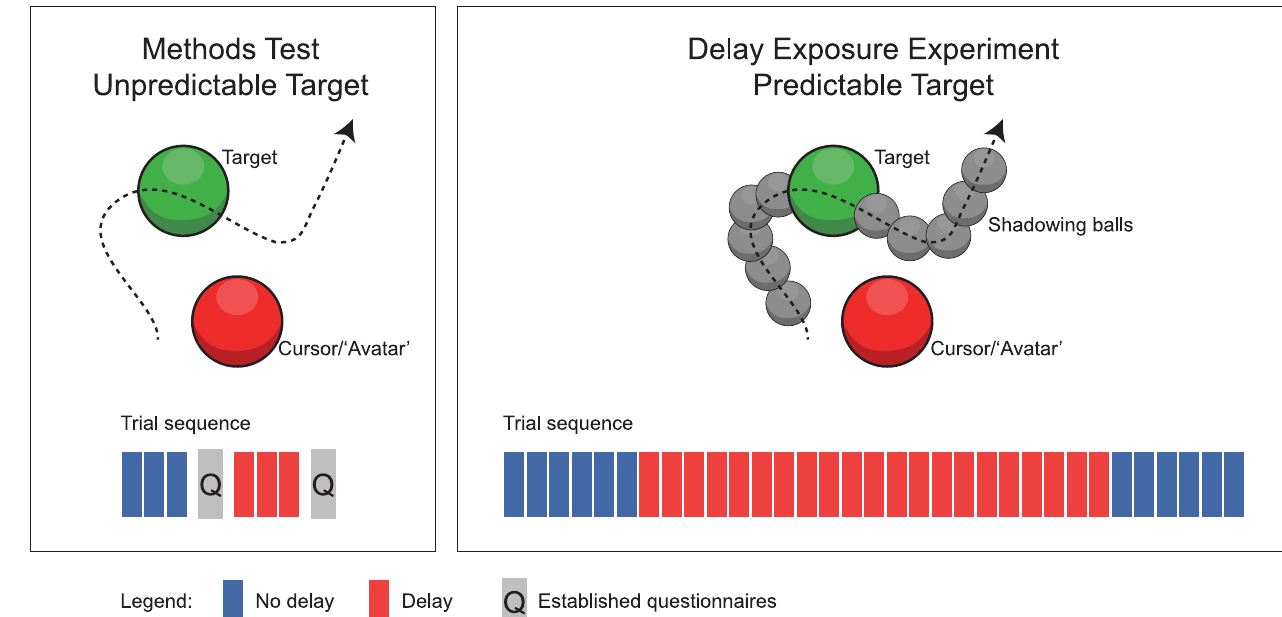
Fig 1. Schematic representation of stimulus and procedure of the experiment. The experiment consisted of two stages. In the first stage participants performed three trials for each of the No-Delay and Delay conditions after which they filled in the established questionnaires (left panel). In the second stage (right panel) participants first performed 6 pre-test trials without delay, then 21 adaptation trials with the added feedback delay of 200 ms and then 6 post-test trials without the delay. During the second stage of the experiment the target movement was rendered predictable by adding the shadowing balls which provided a 2 sec temporal window of the movement path of the target (up to both 1 sec ahead and 1 sec trailing the actual target position).